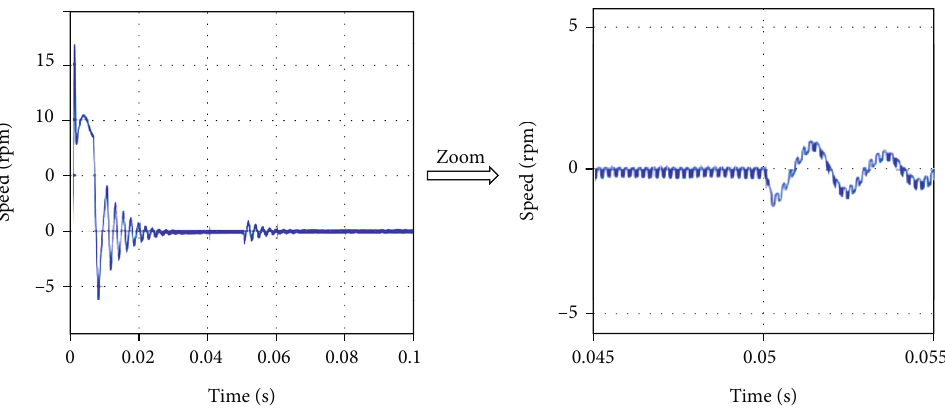
Figure 26: Speed estimation error using the proposed